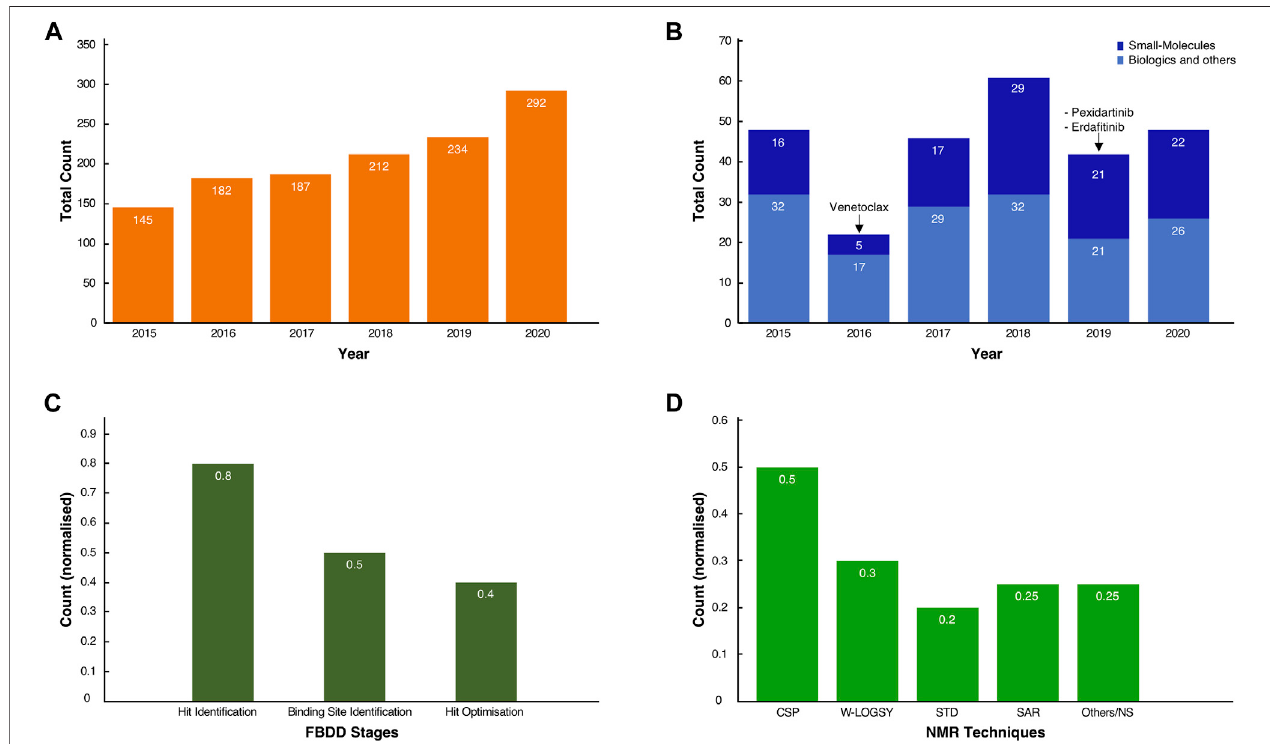
FIGURE 1 | Usage of FBDD methods in the development of new molecules. (A) Total count of journal articles from Jan-2015 to Dec-2020 retrieved by querying “ NMR and Fragment-based Drug discovery ” in the PubMed Central database (see Supplementary Materials for the conditional query script). (B) Total count of FDA- approved New Molecular Entities (NMEs) and original biologics for the same time range. In dark blue, the small molecule NMEs, including the three known drugs whose fragment origins were derived from NMR studies. In light blue, the approved biologics, such as antibodies and oligonucleotides, and other chemicals entities such as diagnostics, combinations of old drugs, natural products. (C) Normalised scores of the occurrences of NMR spectroscopy as a technique in the discovery and development of molecules across the inspected cases. (D) Normalised scores for the total count of the various NMR techniques used throughout the drug discovery process of the inspected cases. Note that for both (C,D) , some compounds have been through multiple stages of drug discovery by NMR, so fractions sum to values >